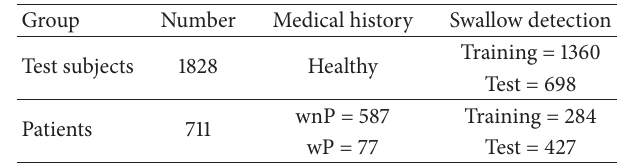
Table 2: Summary of